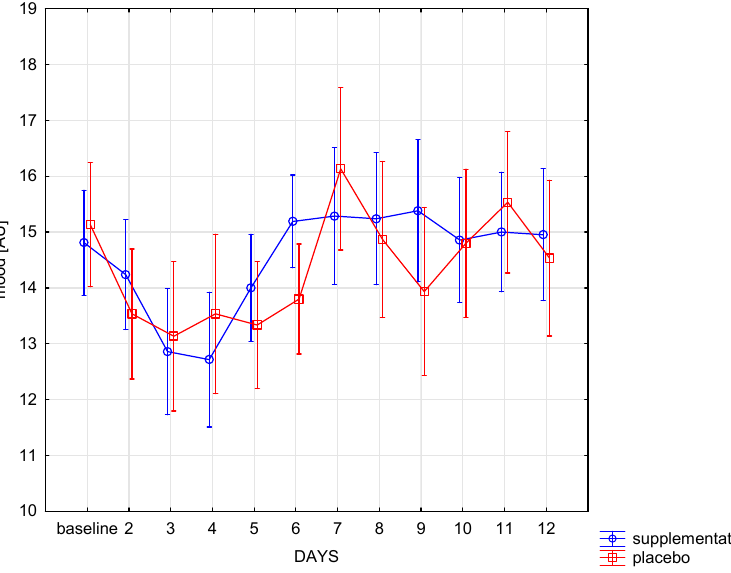
Figure 5. The point sum in sRPE scale in subsequent days in SUP and PL groups. There were no significant interactions between the analyzed factors (group × days) (sRPE: f = 1.13, p = 0.33; CK: f = 0.35, p = 0.87; LDH: f = 2.04, p-0.07; mood: f = 1.39, p =